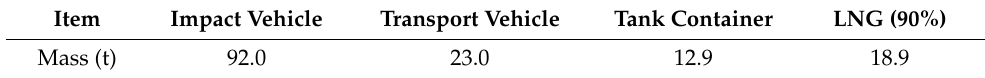
Table 4. Mass of each model component.